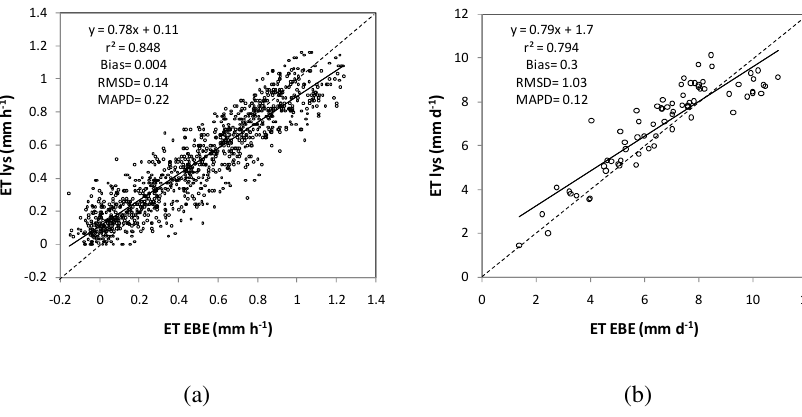
Figure 6. Modelled (STSEB) versus measured (lys) sorghum evapotranspiration: (a) hourly values, (b) daily values. Results of the linear regression fit, together with the main statistics of the comparison (Bias, RMSD, and MAPD), are also included. 5 RMSD value of ± 0.9 mm d − 1 and underestimation of 6 % was observed when daily ET values were calculated using the standard FAO56 methodology (Allen et al., 1998). These results are in agreement with some recent